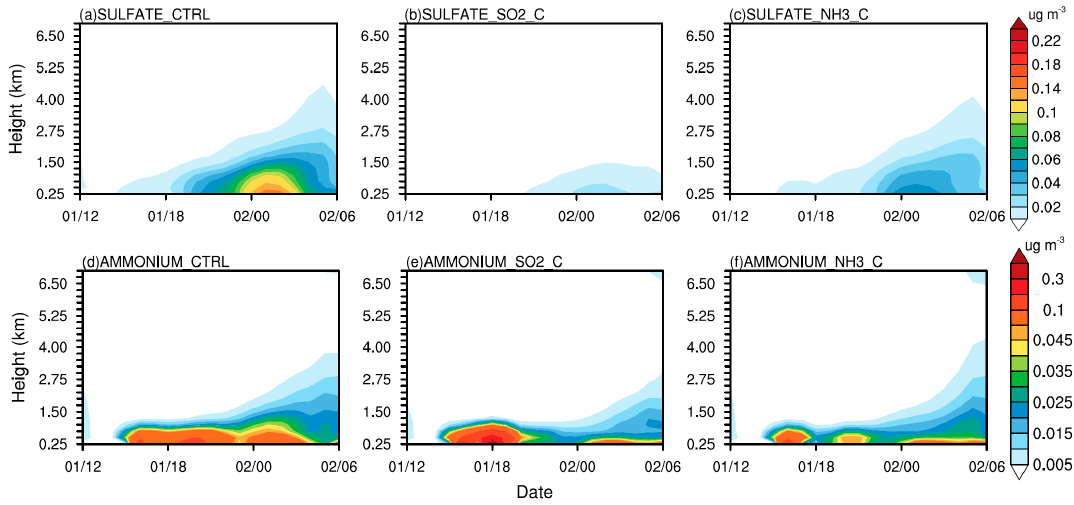
− and ( d – f ) NH + ( µ g m − 3 ) within 150-km 4 4